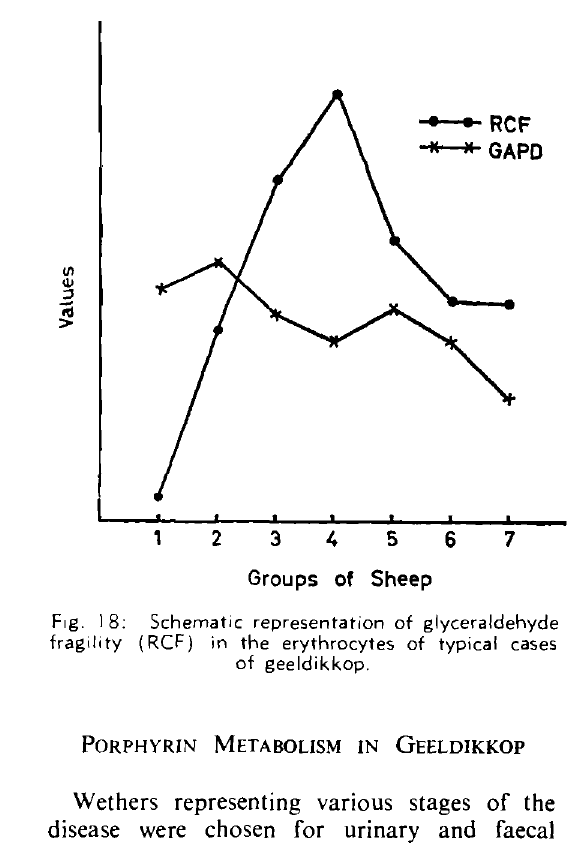
Fig. 18: Schematic representation of glyceraldehyde fragility (ReF) in the erythrocytes of typical cases of geeldikkop.